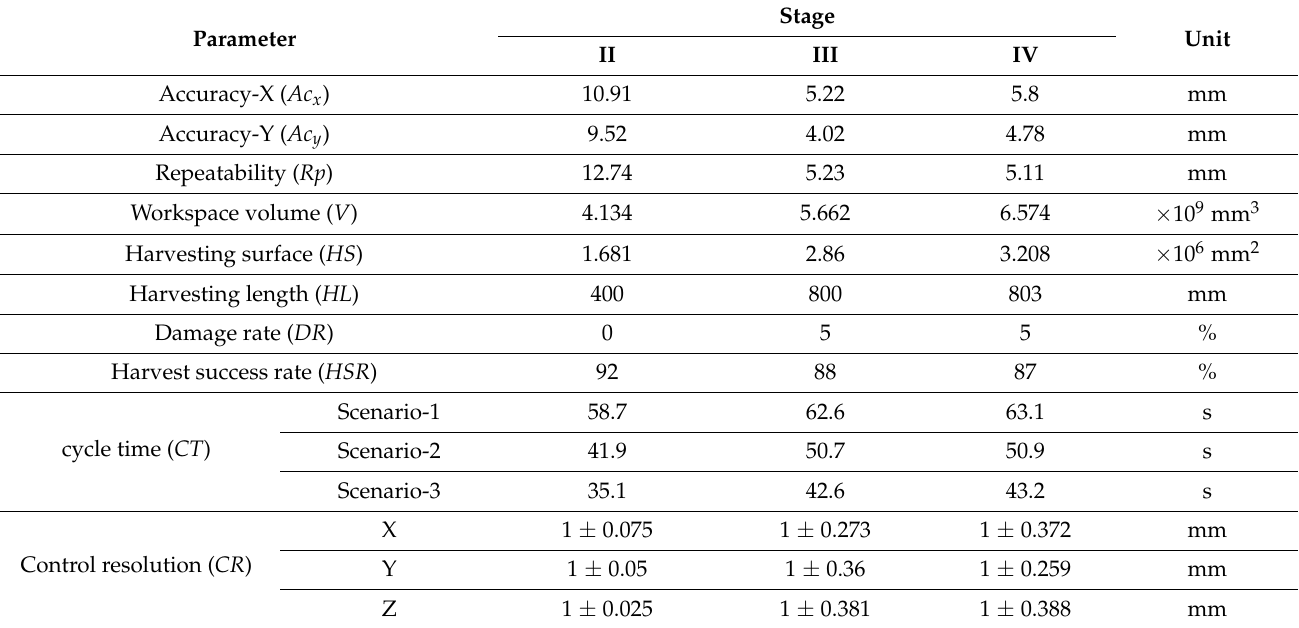
Table 7. Performance indicators of HRHC